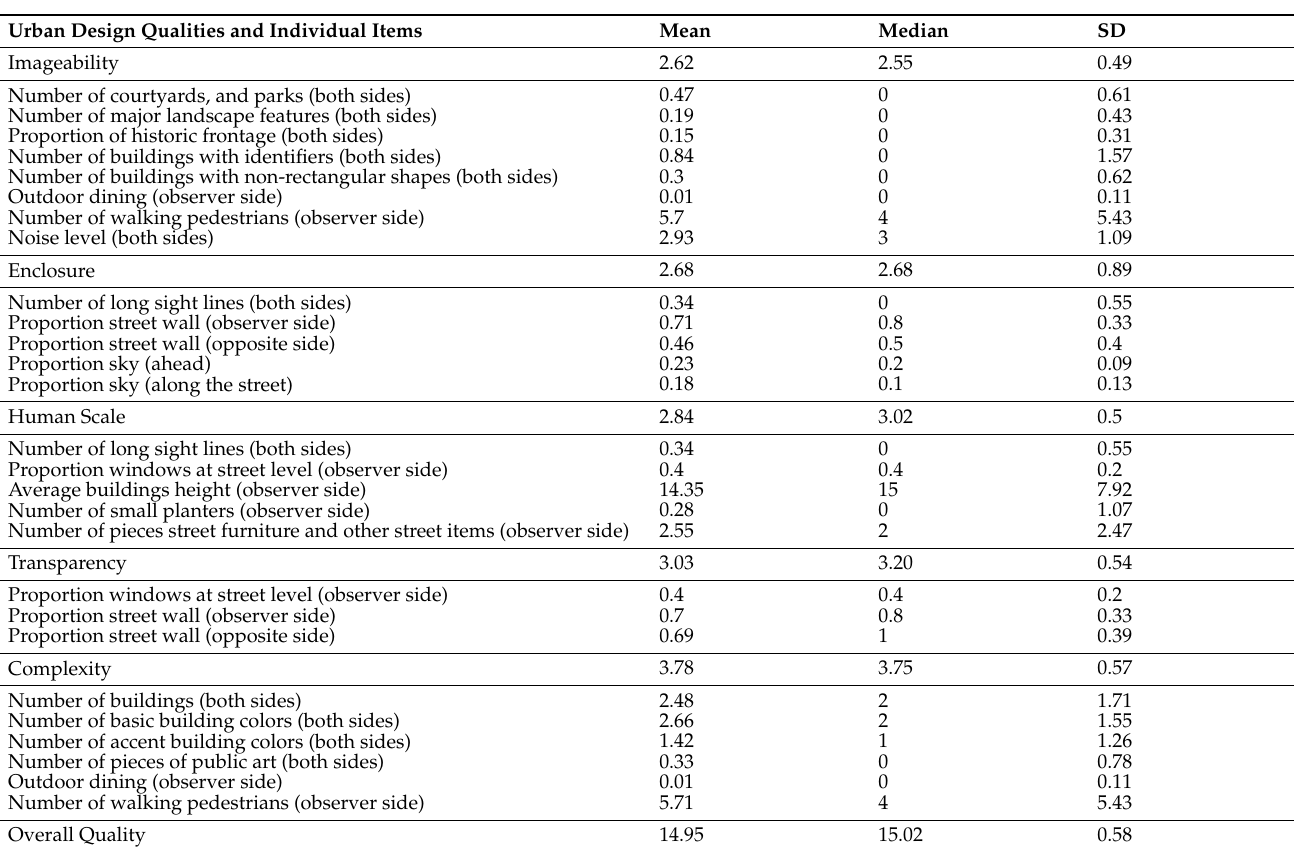
Table 4. Mean, Standard Deviation, and Median for Urban Design Qualities and Individual Items for the selected